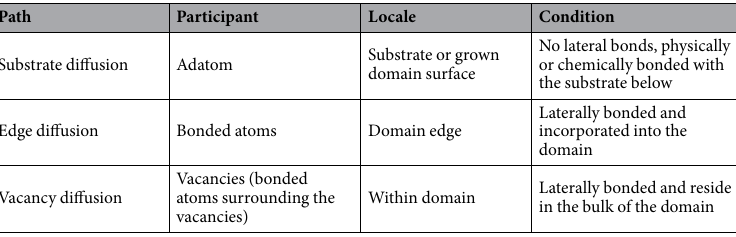
Table 1. The participant, locale and condition of the different diffusion paths included in this